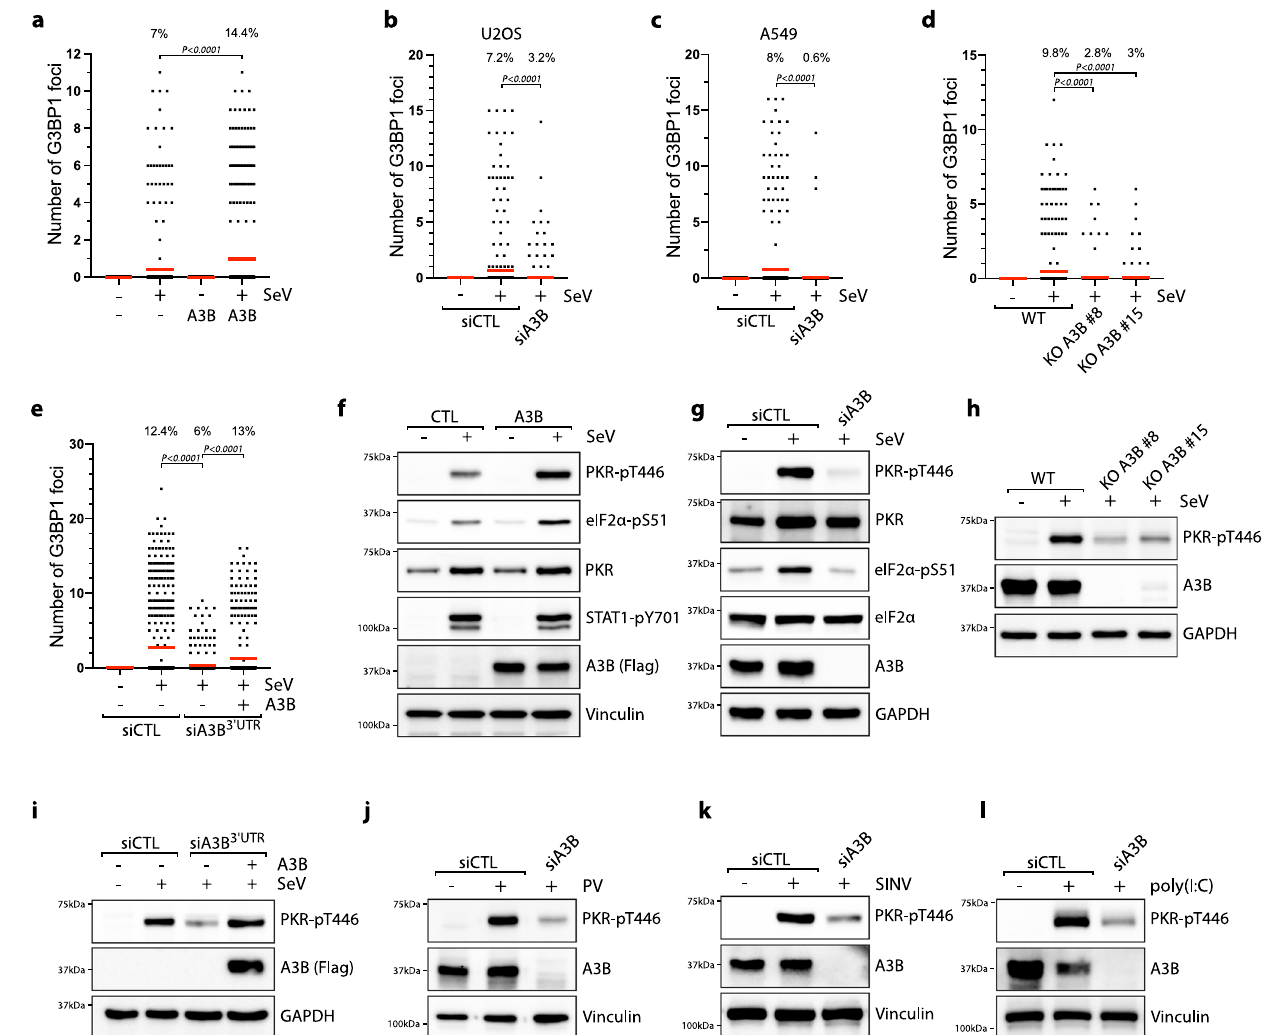
Fig. 3 | APOBEC3B promotes PKR activity during viral infections. a Quanti fi cation of the number of G3BP1 foci by cell in U2OS-A3B- fl ag cells ± DOX and infected with SeV (MOI=1, 24hpi). Top; percentage of cells with G3BP1 foci. Red lines indicate the mean (Number of cells, n =500). P -values were calculated with a two-tailed Welch t -test. b , c U2OS or A549 cellswere transfected with siRNA against A3B for 40h and subsequently infected with SeV at MOI=1. At 24hpi, the levels of G3BP1 foci were quanti fi ed by immuno fl uorescence. Top; percentage of cells with G3BP1 foci. Red lines indicate the mean (Number of cells, n =500). P - values were calculated with a two-tailed Welch t -test. d Quanti fi cation of the numberofG3BP1fociinU2OSKOA3BcellsinfectedwithSeV(MOI=1,24hpi).Top; percentage of cells with G3BP1 foci. Red lines indicate the mean (Number of cells, n=500). P -values were calculated with a two-tailed Welch t -test. e U2OS-A3B- fl ag cells ± DOX weretransfected with a siRNA targeting the 3 ′ UTR of endogenous A3B mRNA or a control (siCTL) for 40h. The levels of G3BP1 foci were quanti fi ed by